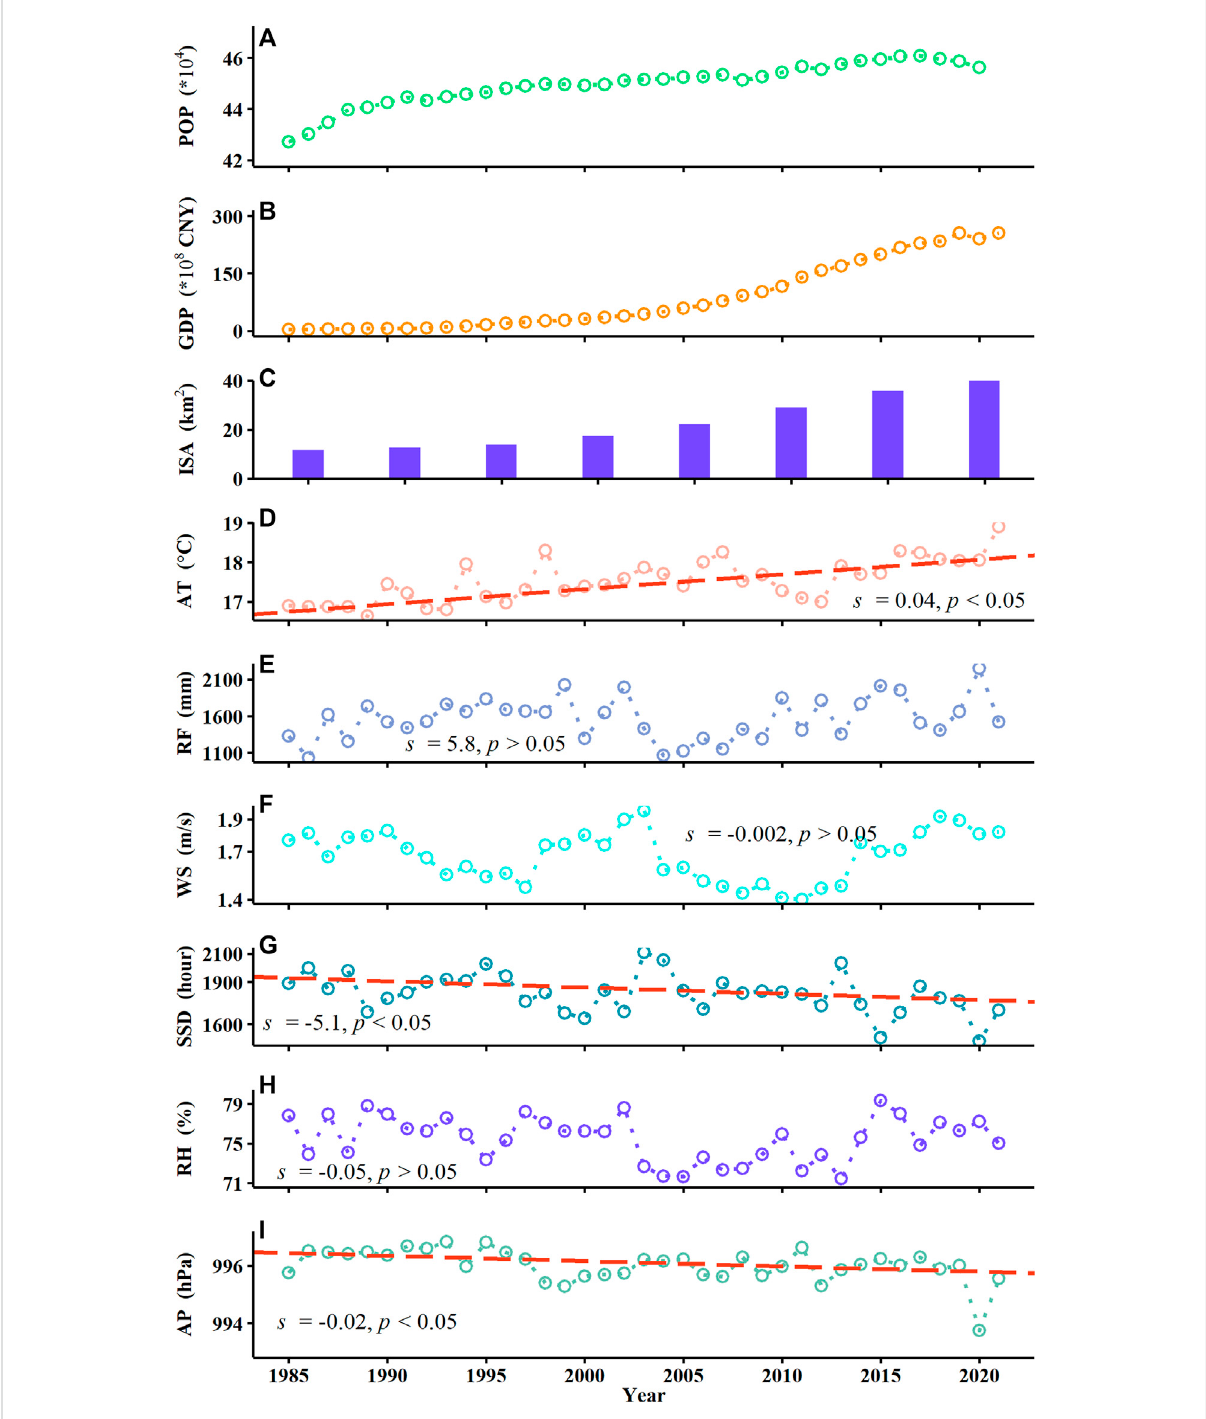
FIGURE 9 Long-term (1985 – 2021) changes in POP (A) , GDP (B) and ISA (C) , AT (D) , RF (E) , WS (F) , SSD (G) , RH (H) and AP (I) . s represents the Sen ’ s